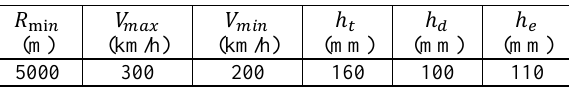
Table 5. Limit values for geometric parameters